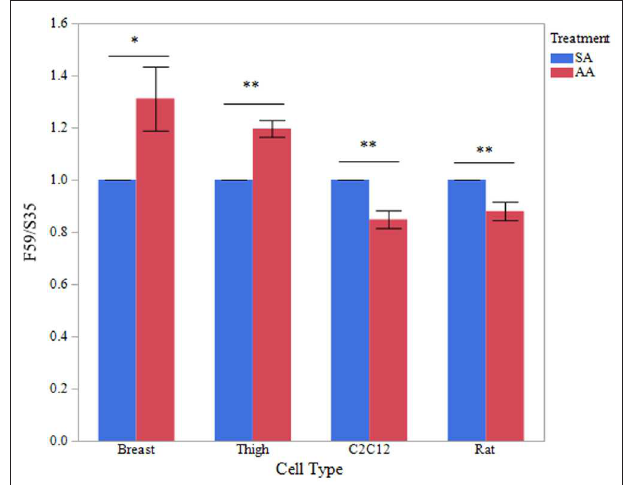
FIGURE 9 | Fast to slow MHC ratio between treatments. Western blot densitometry of sodium acetate (10mM) or ammonium acetate (10mM) treated myotubes from primary breast, primary thigh, C2C12, and primary rat cultures for fast (F59) and slow (S35) myosin heavy chain isoforms ( n = 5). Relative MHC expression is presented as a ratio of fast to slow MHC isoform expression. Asterisk represent significant differences between treatments for each cell type (* P < 0.05; ** P < 0.01).